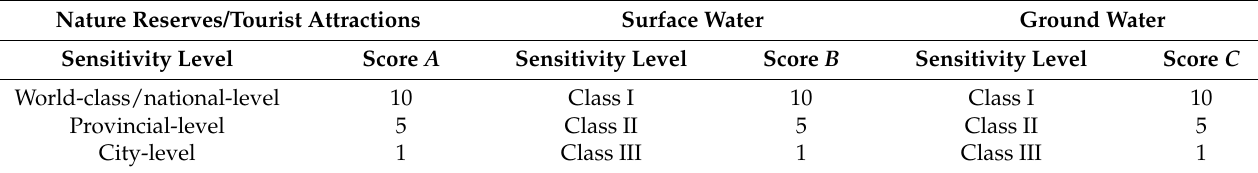
Table 2. Scores of protected areas at different sensitivity levels.